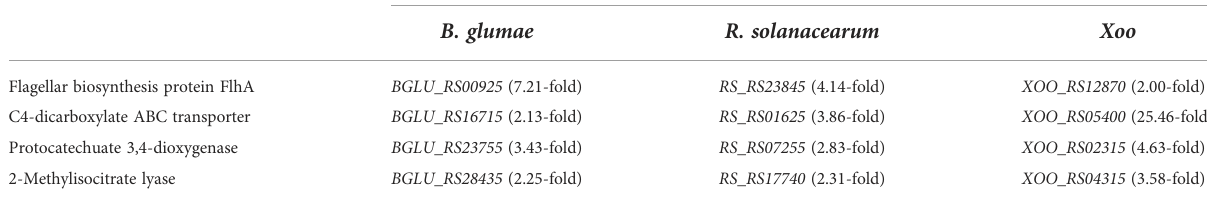
TABLE 1 List of co-upregulated DEGs in the core genome.